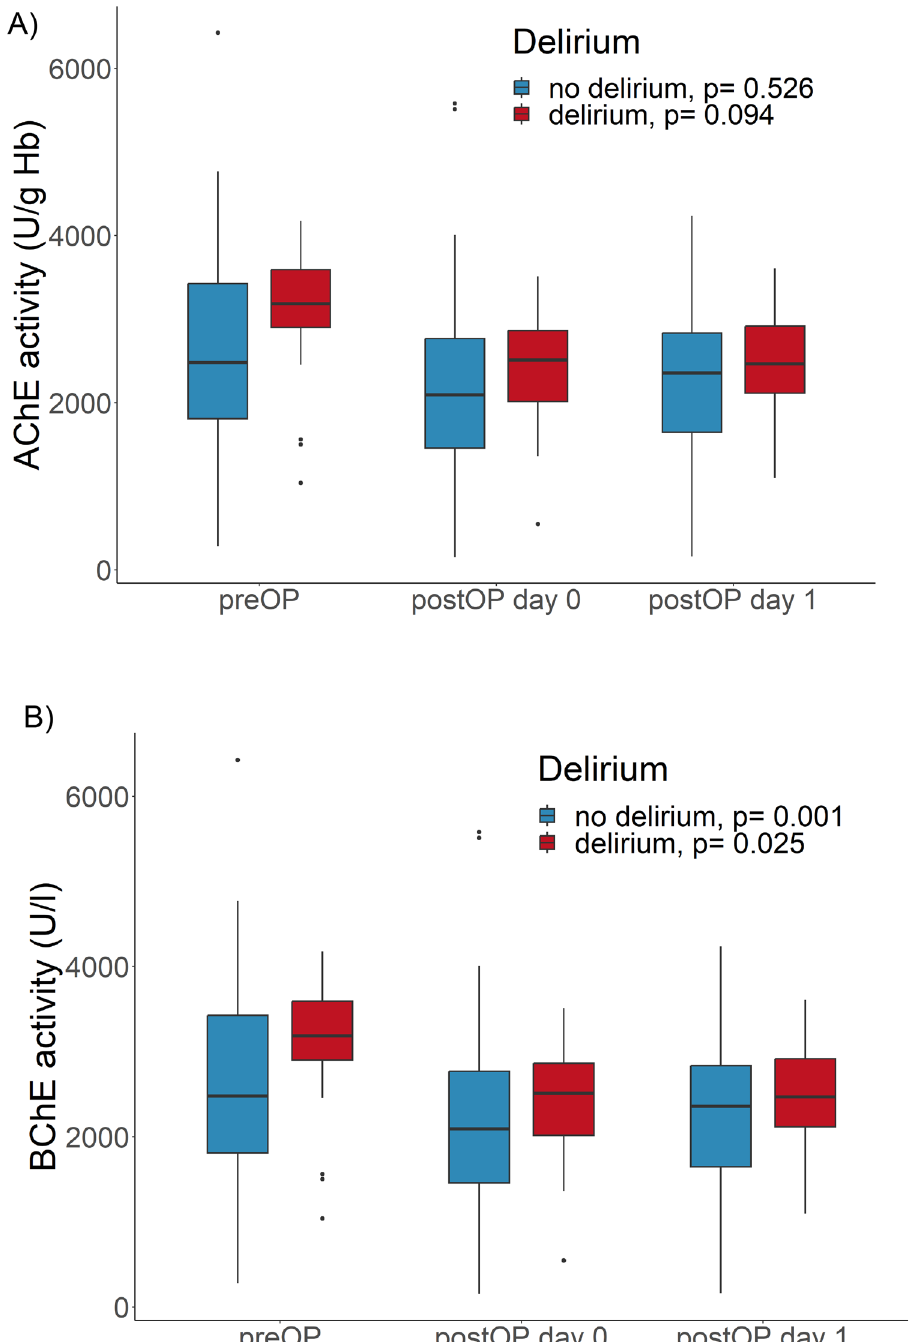
Figure 3. Activities of cholinesterases. ( A ) Activities of acetylcholinesterase (AChE) ( B ) Activities of butyrylcholinesterase (BChE) before (preOP), 15 min after (postOP day 0) and one day after surgery (postOP day 1) compared between patients without delirium (no delirium, blue, n = 42) or patients with delirium (delirium, red, n = 14). The Boxplots show median and IQR (lower and upper hinges). P -values compare values of all three points in time within each group, using the Friedman rank